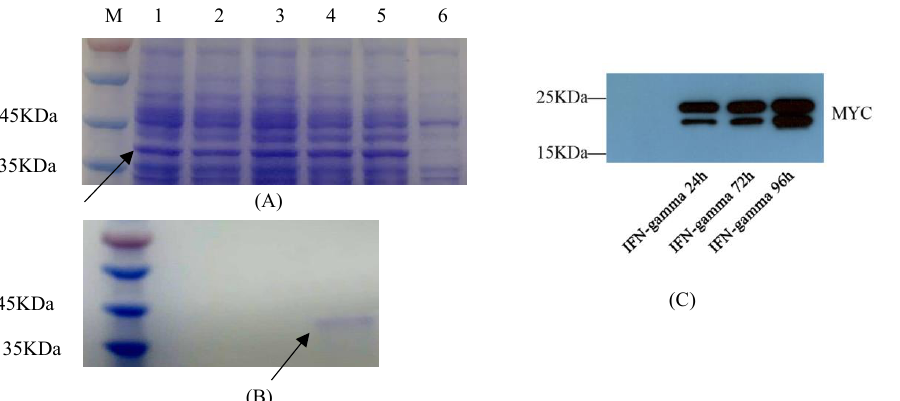
Figure 4. Exogenous expression of GmIFN– γ . ( A ) Optimization of prokaryotic expression conditions. Nos. 1–5 indicate that the protein was induced for 1–5 h. No. 6 was set as the control. Target protein was marked by arrow. ( B ) Purification of GmIFN– γ from E. coli . Target protein was marked by arrow. ( C ) GmIFN– γ expressed in yeast GS115 and detected using Western blot at 24, 72 and 96 h, respectively.